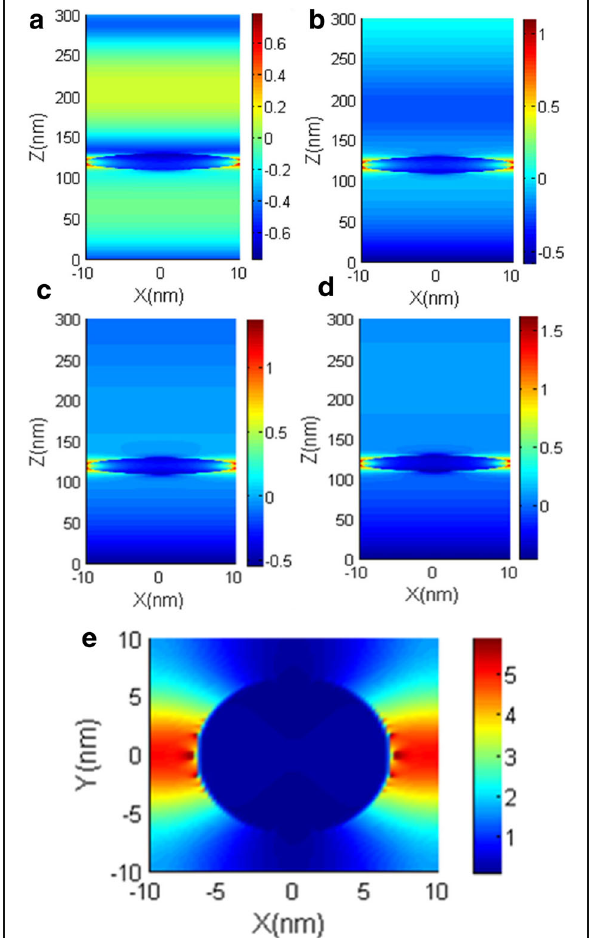
Fig. 5 Electric field magnitude distribution (log 10 | E / E 0 |) of single-MD-layer NPA: Electric field magnitude distribution in y =0